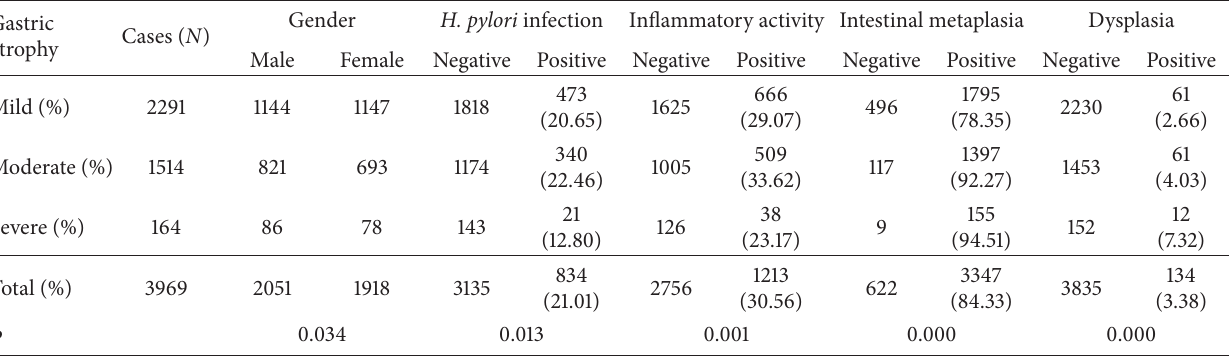
Table 4: The distribution of H. pylori infection, inflammatory (neutrophil) activity, intestinal metaplasia and dysplasia according to the grade of gastric atrophy.